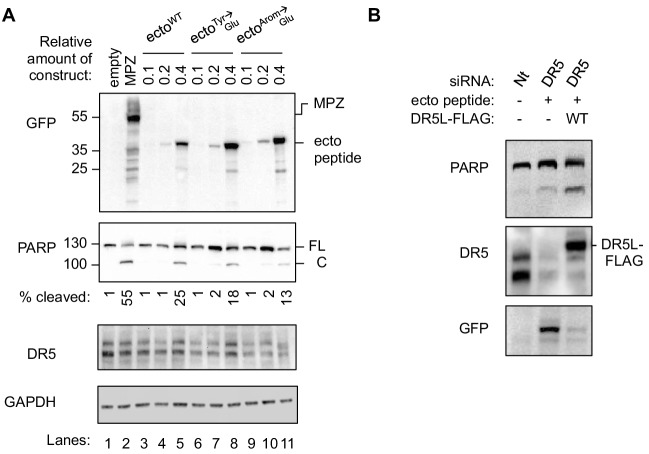
Introducing Glu mutations to the DR5-binding sequence of MPZ disrupts PARP cleavage in a DR5-dependent manner.(A) Western blot of HepG2 cell lysates harvested 24 hr post-transfection with 1 μg of the empty vector, MPZ-GFP, or a titration of GFP-tagged MPZ-ecto peptide variants. FL denotes full-length PARP, while C denotes cleaved PARP. The percentage of cleaved PARP was calculated as the signal of cleaved PARP divided by total PARP (FL + C). (B) Western blot of HCT116 cell lysates transfected with siRNA against a non-targeting (Nt) sequence or DR5 (referred to as DR5-siRNA-2 in Materials and methods) for 48 hr and co-expressing FLAG-tagged DR5 long isoform and/or MPZ-ecto peptide-GFP.